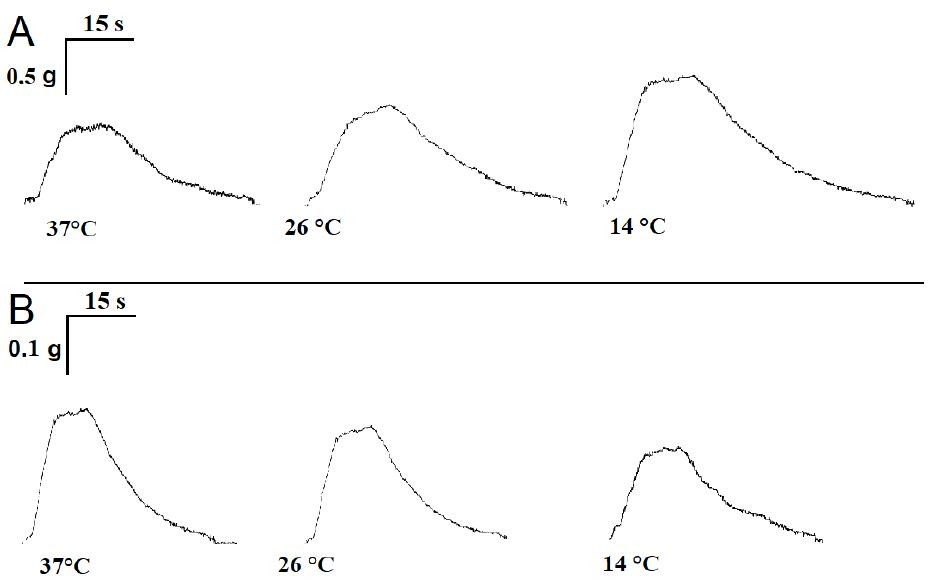
Figure 5. View of single contractile responses of m. soleus ( A ) and m. EDL ( B ) induced by carbachol stimulation at different temperatures.